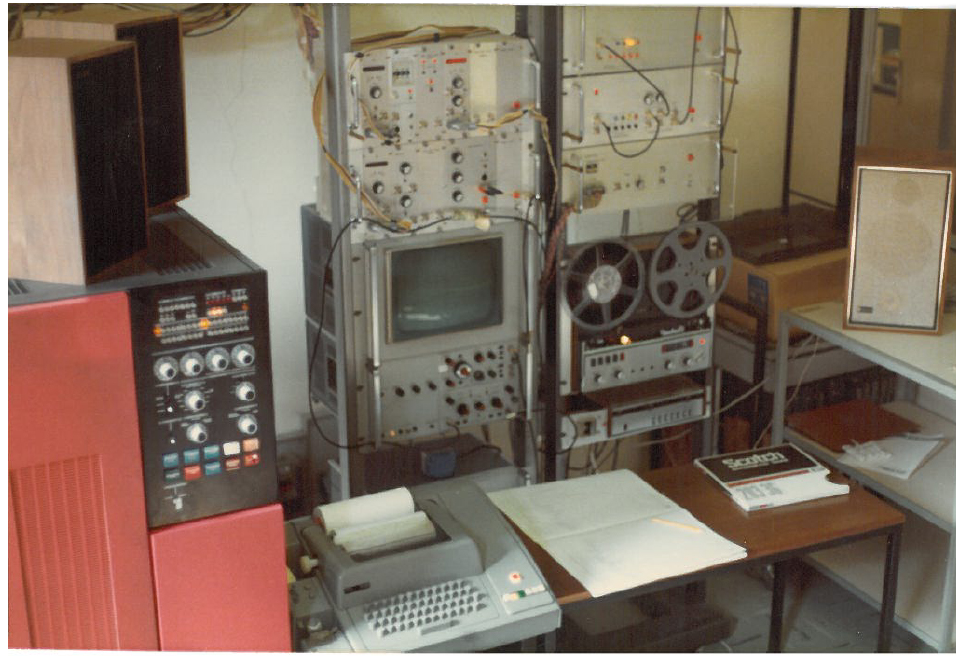
Figure 2. Hardware and software systems used by CSC in 1979 for recording, sound synthesis and music